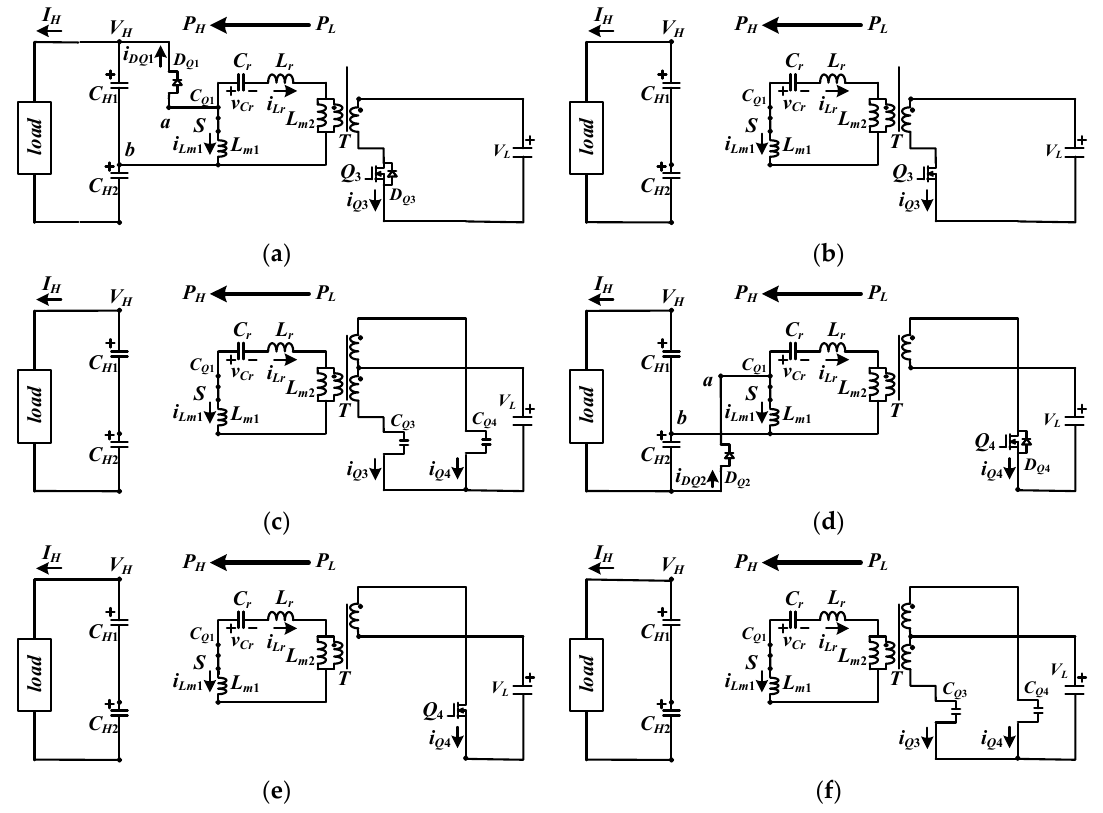
Figure 5. Equivalent topological circuits at reverse power transfer ( a ) mode 1 ( b ) mode 2 ( c ) mode 3 ( d ) mode 4 ( e ) mode 5 ( f ) mode 6.